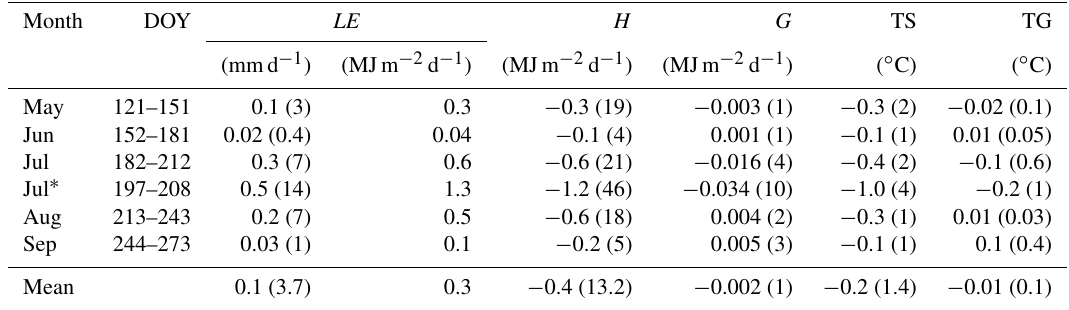
Table 7. Mean differences in latent heat flux ( LE ), sensible heat flux ( H ), ground heat flux ( G ), surface temperature (TS) and ground tem- perature (TG) between Run 1 and Run 2 simulations. Numbers in parentheses: the relative difference between Run 1 and Run 2 simulations as a percentage.